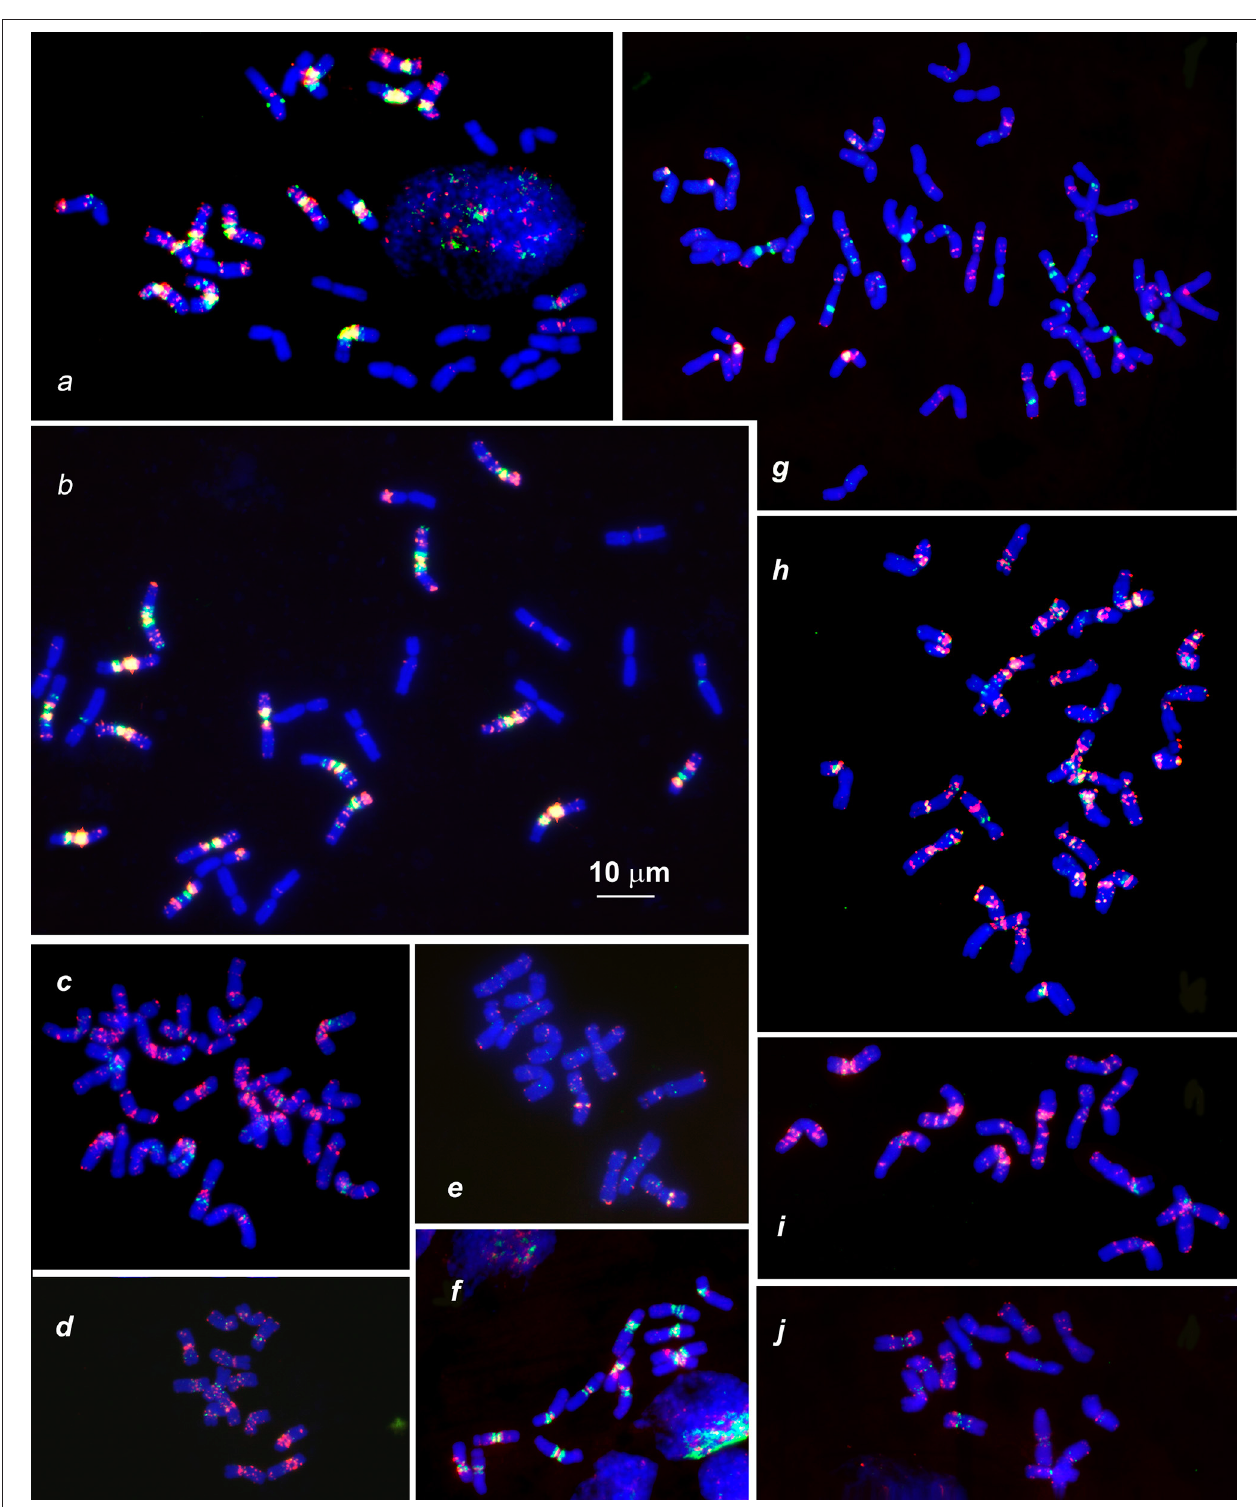
FIGURE 3 | Distribution of (CTT) 10 and (GTT) 9 probes (red and green colors respectively) on chromosomes of wheat and Aegilops species: (a) , Triticum dicoccoides (IG 46396); (b) , T. araraticum (IG 116164); (c) , Ae. kotschyi (TA2206); (d) , Ae. longissmia (AE 904); (e) , Ae. searsii (AE 1071); (f) , Ae. speltoides (C1, Technion park, Israel); (g) , Ae. vavilovii (K-3637); (h) , Ae. peregrina (C11, Nahal Mearot, Israel); (i) , Ae. sharonensis (C6, Keshon, Israel); (j) , Ae. bicornis (K-666). Scale bar, 10 µ m.